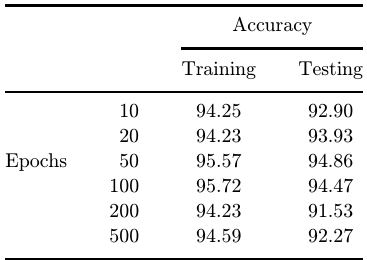
Table 1. CNN model performance with respect to accuracy.